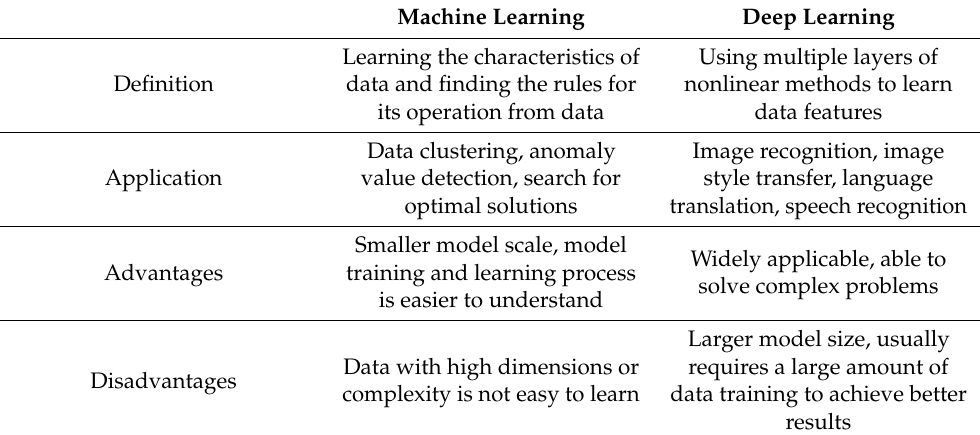
Using multiple layers of data features Image recognition, image style transfer,